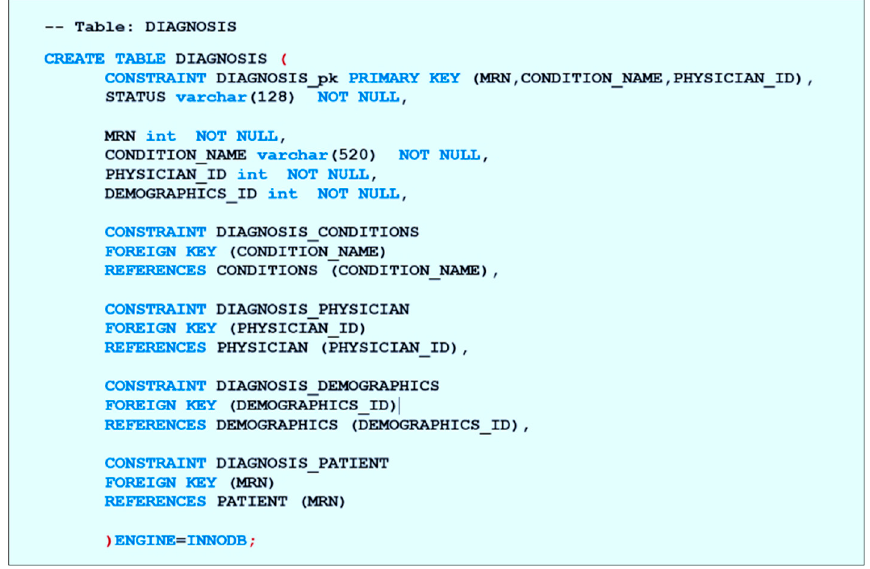
Figure 12. SQL script for creating the “DIAGNOSIS” table.